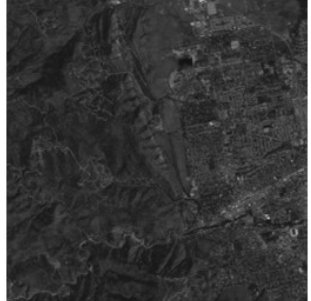
Figure 12. The PP-2D-CCI for georeferenced imagery interpolation with different parameters a based on FPGA. (a) a =